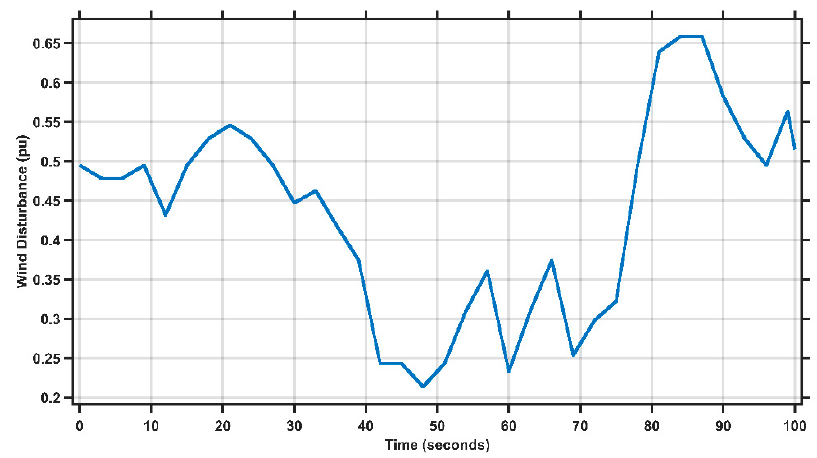
Figure 9. Wind disturbance.